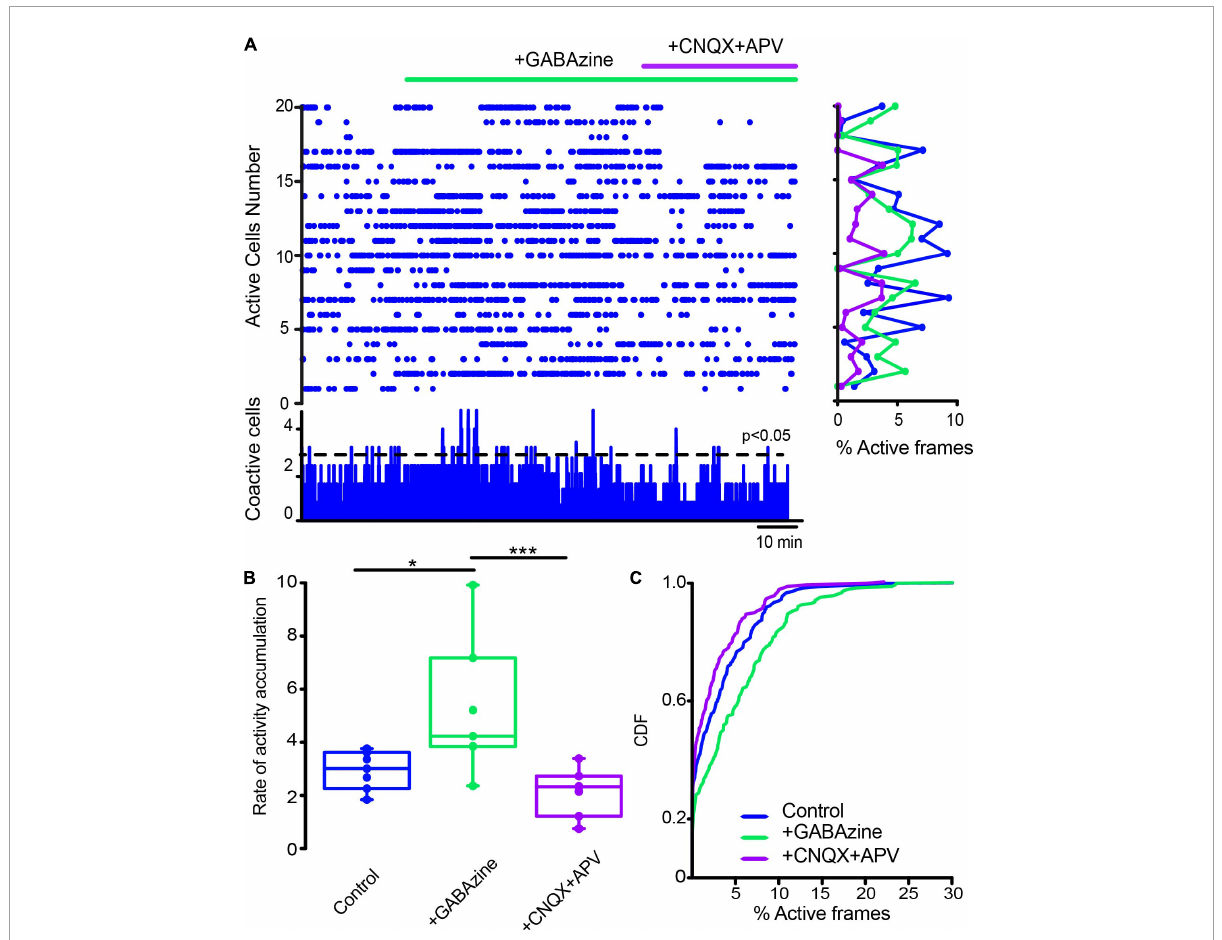
FIGURE9 Global actions of inhibitory GABAergic inputs during CINs spontaneous activity in control conditions. (A) Raster plot represents the simultaneous activity of CINs before and after applying 10 µ M GABAzine: an increase in activity is reflected cell by cell (rows activity at right histogram) and is significant at the level of coactivity peaks (histogram at the bottom; * P = 0.039; Wilcoxon T). An addition of 10 µ M CNQX + 50 µ M APV appears to decrease this activity. (B) Box plots show the rate of activity accumulation. Blockade of glutamatergic transmission does inhibit activity after GABAzine (*** P = 0.0002; Friedman ANOVA with post hoc Dunn’s test). (C) Cumulative distribution functions (CDFs) of activity of ChAT+ identified neurons in control conditions and during synaptic antagonists: control vs. + GABAzine: P = 0.0033; control vs. + GABAzine + CNQX + APV: P = 0.052; and Gabazine vs. + Gabazine + CNQX + APV: P < 0.0001. (n-control = 111 neurons; + Gabazine = 133 cells; + Gabazine + CNQX + APV = 116 cells from n = 7 slices from 7 different animals; Kolmogorov Smirnov